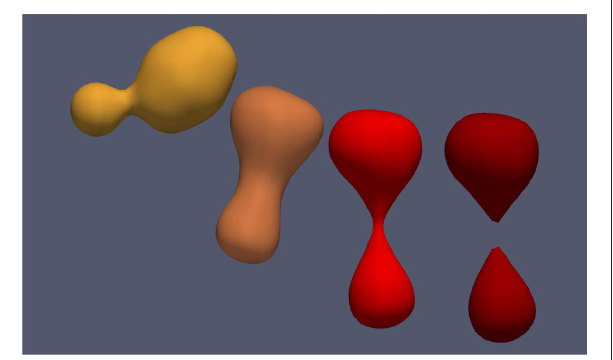
FIGURE 1 | Quasifission in the reaction 48 Ca + 249 Bk at E c.m. = 234 MeV and orbital angular momentum L / ¯ h = 60 and the orientation of the 249 Bk with respect to the collision axis β = 135 ◦ . The darkening of tones depict increasing